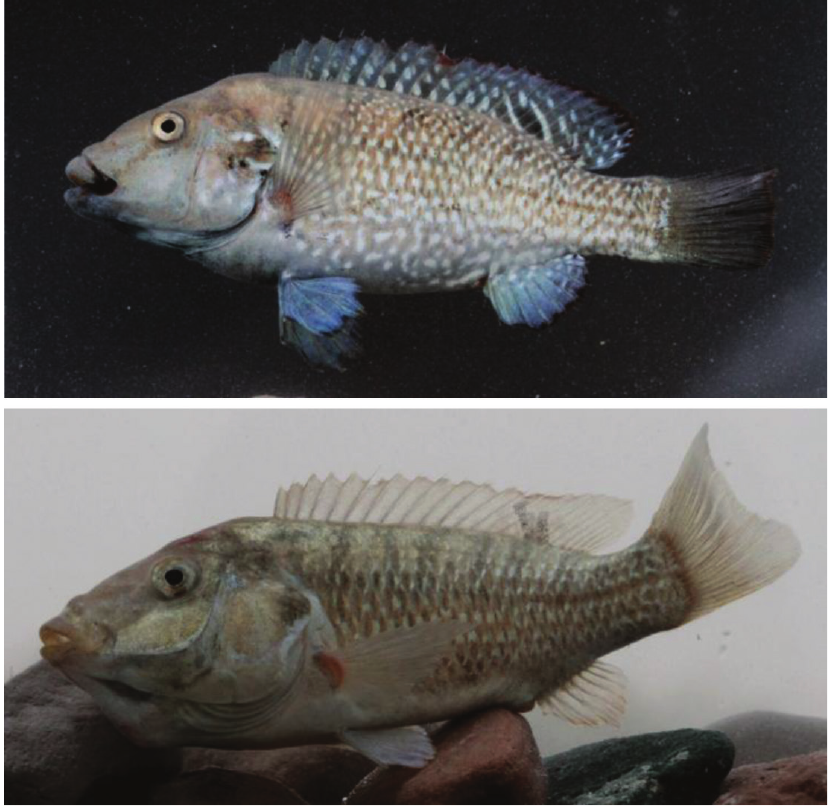
Figure 11. Iranocichla hormuzensis , ZM-CBSU-IH54 male, 93.6 mm SL, ZM-CBSU-IH50 female with eggs, 83.4 mm SL Hormuzgan prov.: Dezhgan, Mehran